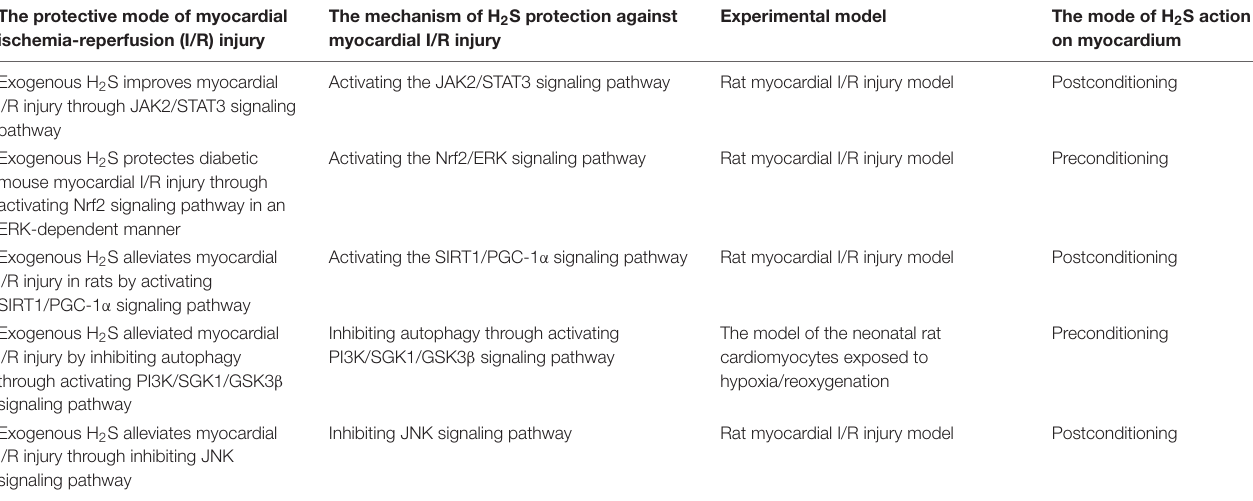
TABLE 1 | The summary of exogenous hydrogen sulfide improvements of myocardial I/R injury. The protective mode of myocardial The mechanism of H 2 S protection against ischemia-reperfusion (I/R) injury myocardial I/R